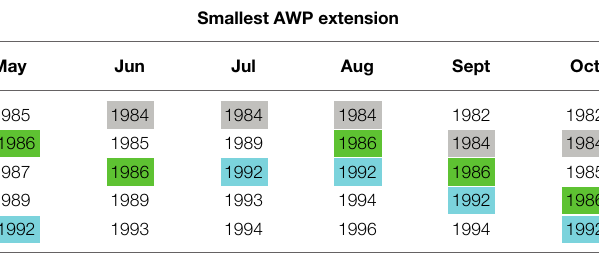
TABLE 2 | Years of smallest AWP area for 1982–1999.